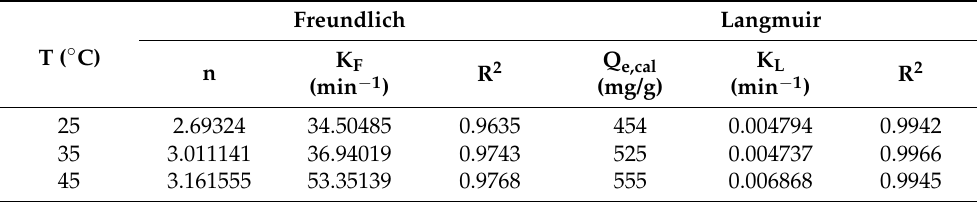
Figure 6. The fitted plots of Freundlich ( a ) and Langmuir ( b ) equations. Table 4. The parameters in the fitted Freundlich and Langmuir models.